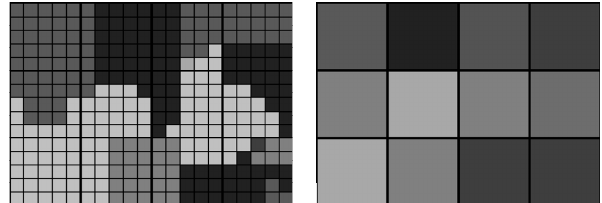
Figure 3. Sub-pixel and pixel level concept (the greyscale represents theoretical radiance